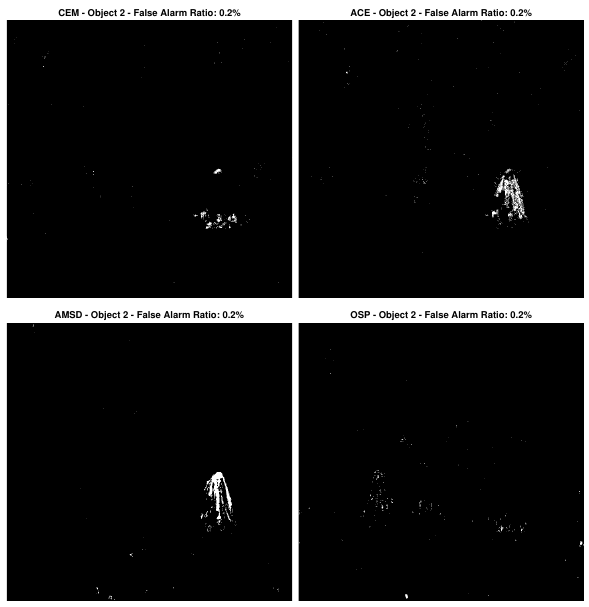
Figure 13. Object 2 target detection.